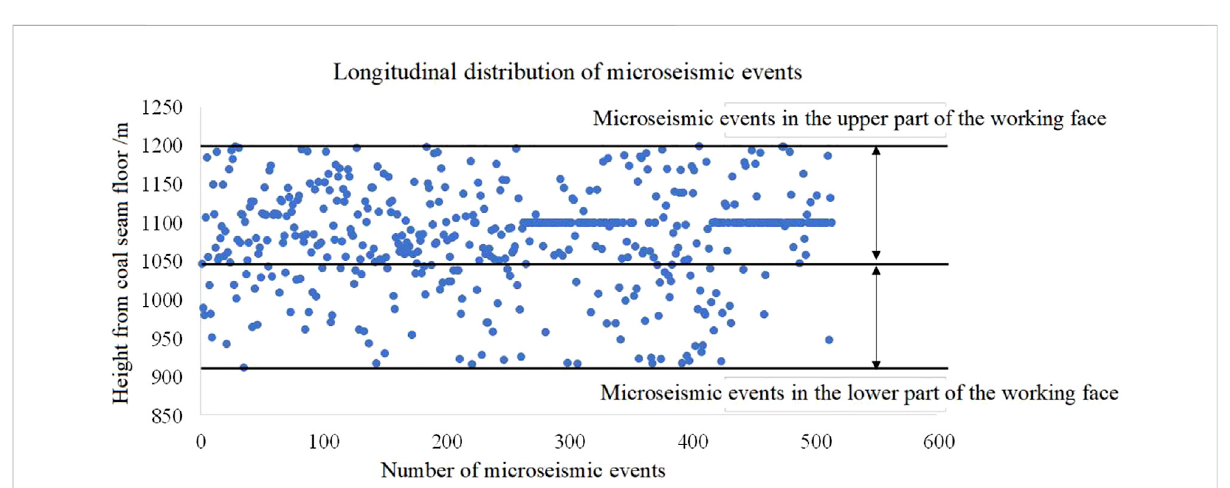
FIGURE 4 Longitudinal spatial distribution range of microseismic